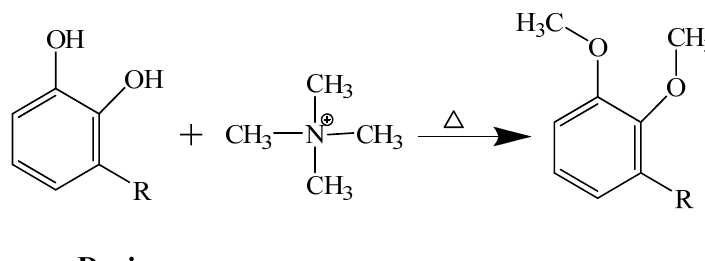
Figure 3. Methylation reaction of urushiol hydroxyl group with TMAH.